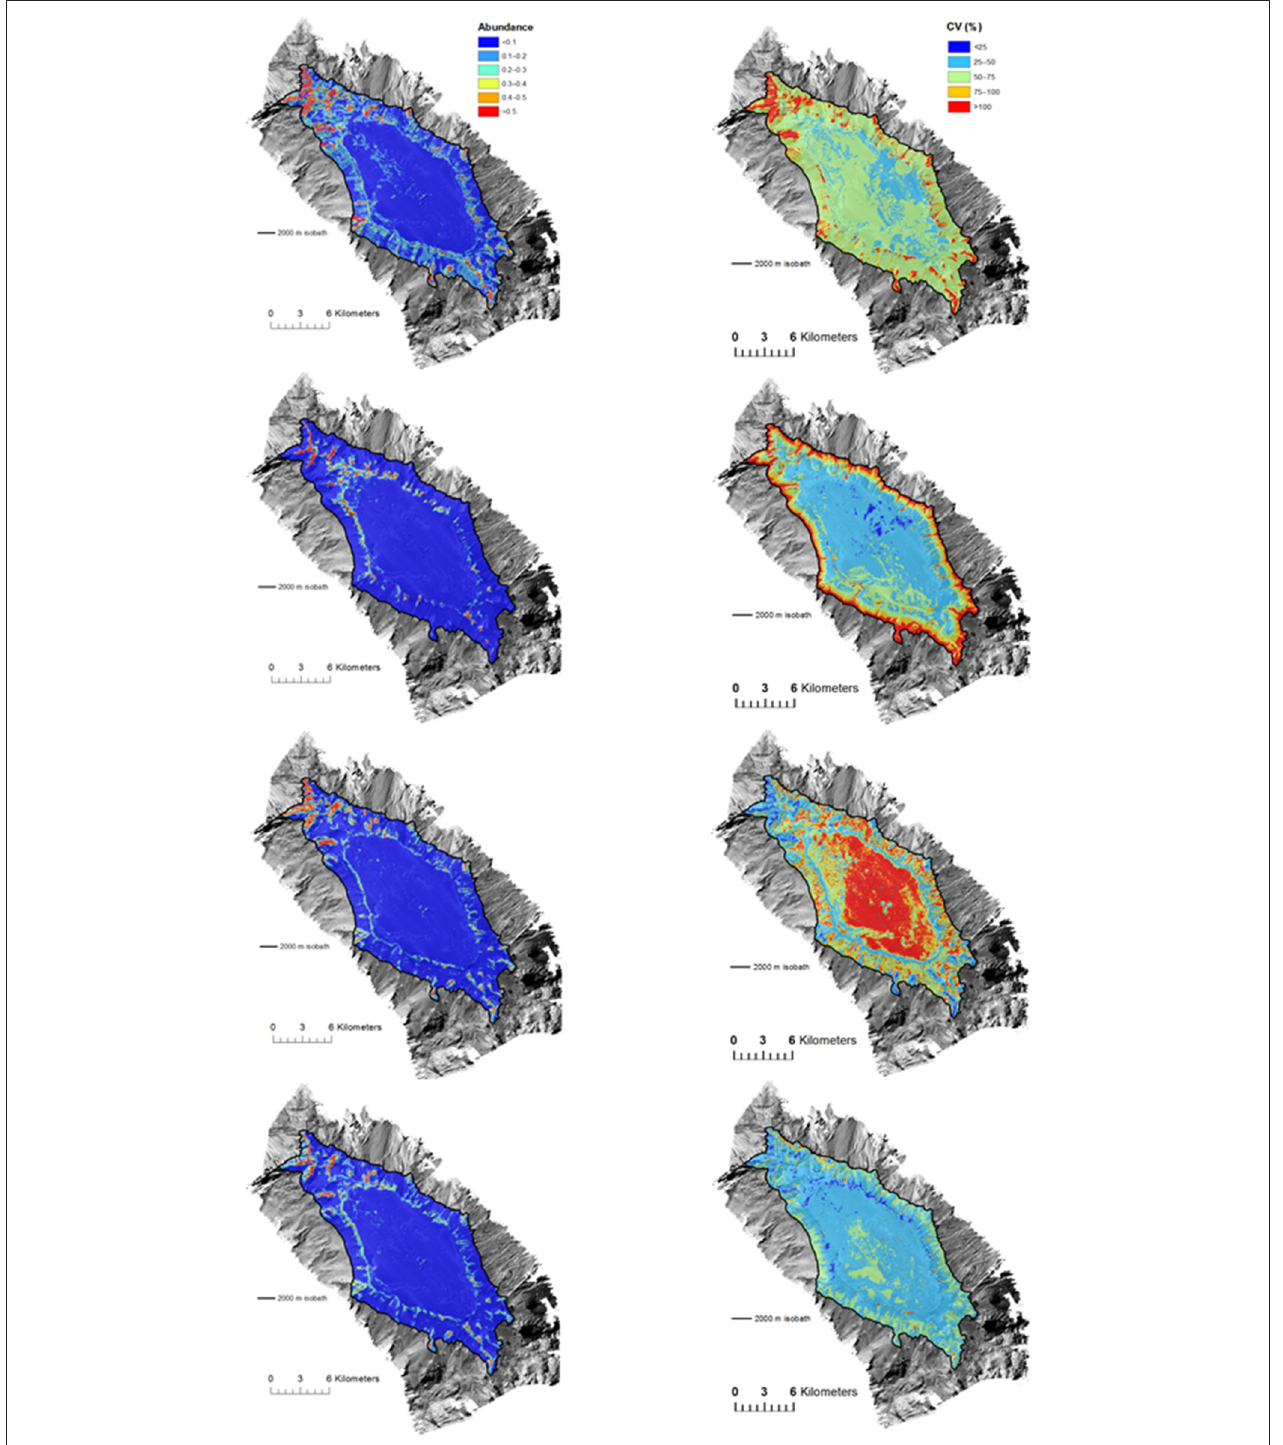
FIGURE 7 | Forde Guyot. Prediction of Solenosmilia variabilis (Left) abundance (number of “live head” colonies per 25 × 25m model cell) and (Right) uncertainty (CV) for (from top to bottom) BRT, GAM, RF, and ensemble habitat suitability models. Color-coded model abundance estimates and CV are draped over the MBES bathymetry obtained during the